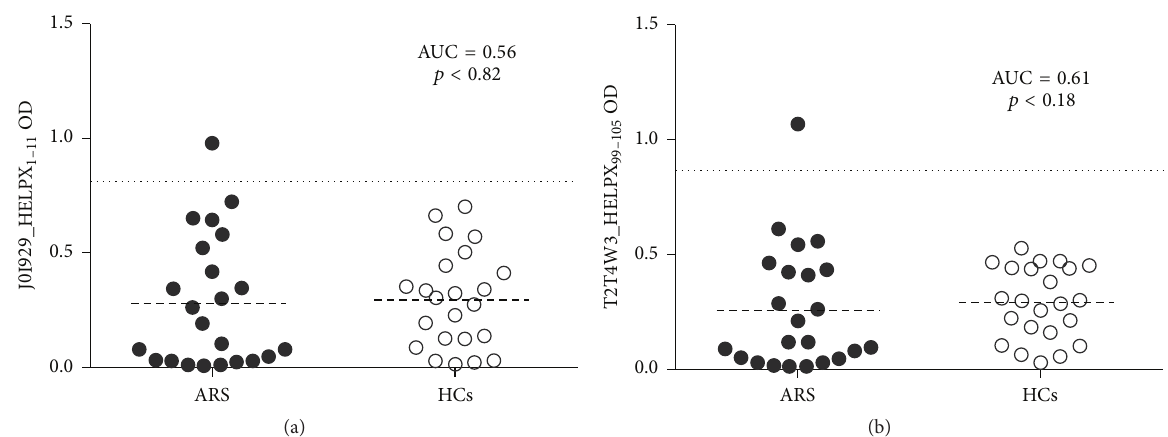
Figure 4: Distribution of anti-HP Abs levels measured by ELISA in T1D at-risk subjects and healthy controls. Sera of 23 ARS and 22 HCs (a) and T2T4W3 HELPX 99 (b). The dotted lines represent cut-off values calculated by were screened for Abs against J0I929 HELPX 1 – 11 – 105 ROC analysis and used to discriminate between positive and negative samples. Dashed lines indicate the respective mean OD values. Area under the curve (AUC) and 𝑝 values are reported in the top-right